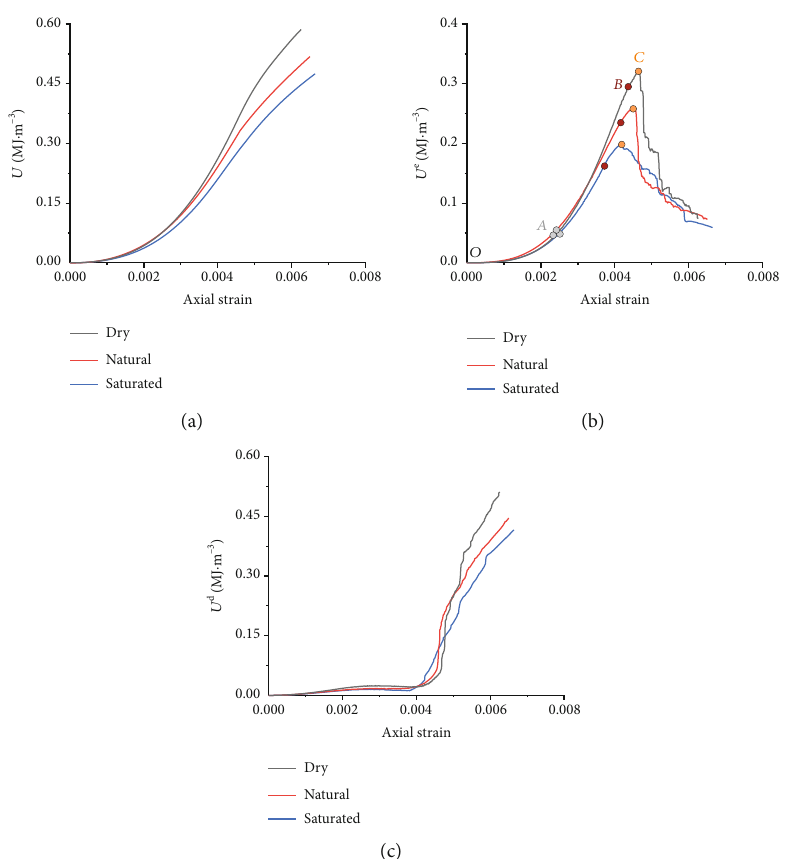
Figure 8: Energy evolution characteristics of granite samples with di ff erent water content states (con fi ning pressure 0 MPa): (a) total input energy; (b) elastic strain energy; (c) dissipation